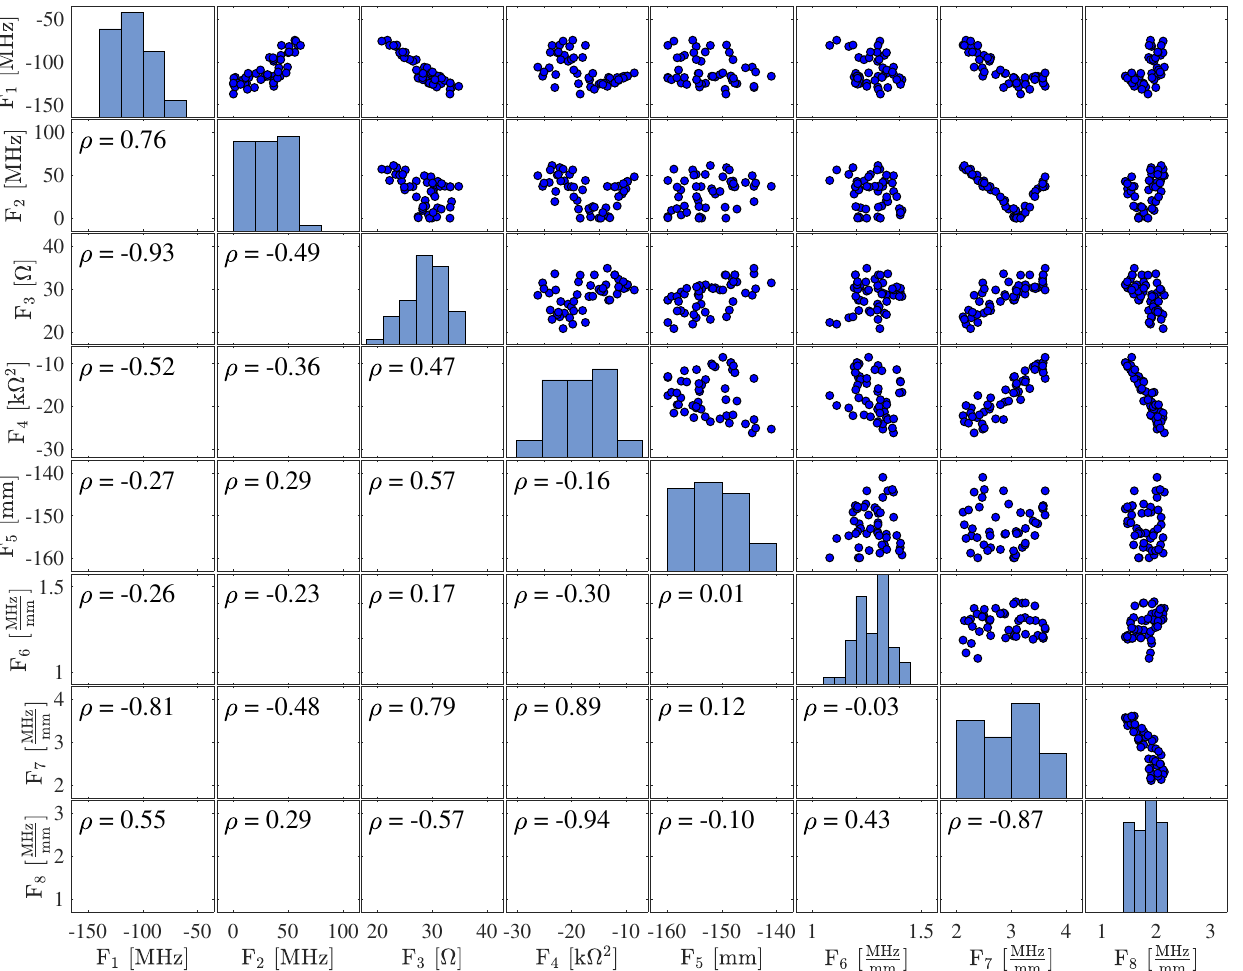
FIG. 9. A scatter plot of the objective functions for the individuals in the last generation. Only individuals with 140 ≤ R i ≤ 160 and 200 ≤ L ≤ 400 are shown in order to preserve the scale. The numbers below the diagonal are the correlation coefficients between pairs of objective functions.